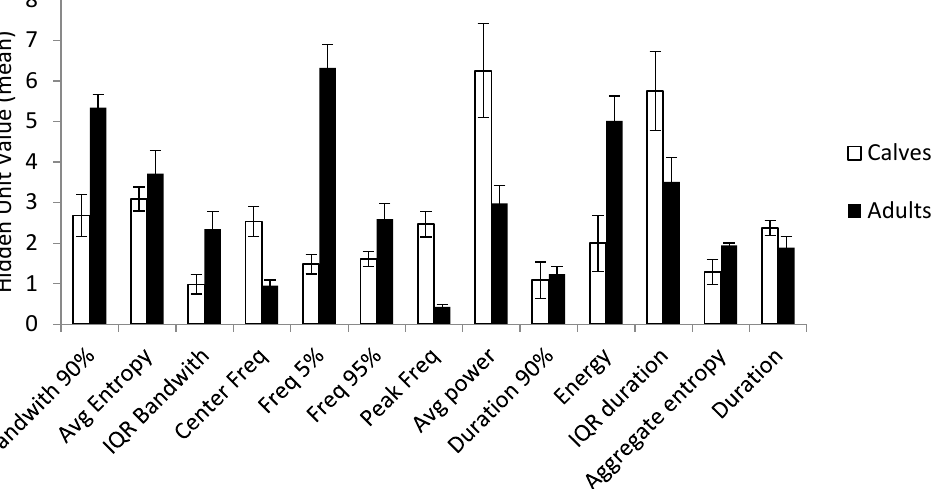
Figure 5 . Mean hidden unit values calculated from the five highest performing NNs trained to distinguish calf whistles from adult whistles. Higher hidden unit values indicate greater relevance to classification of whistles by the network. Bars are standard errors of the